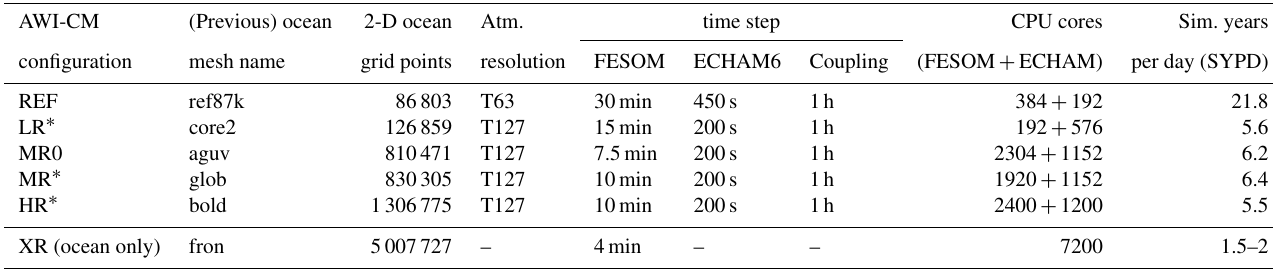
Table 2. Model settings for the different AWI-CM configurations. AWI-CM (Previous) ocean 2-D ocean Atm. time step CPU cores Sim. years configuration mesh name grid points resolution FESOM ECHAM6 Coupling (FESOM + ECHAM)